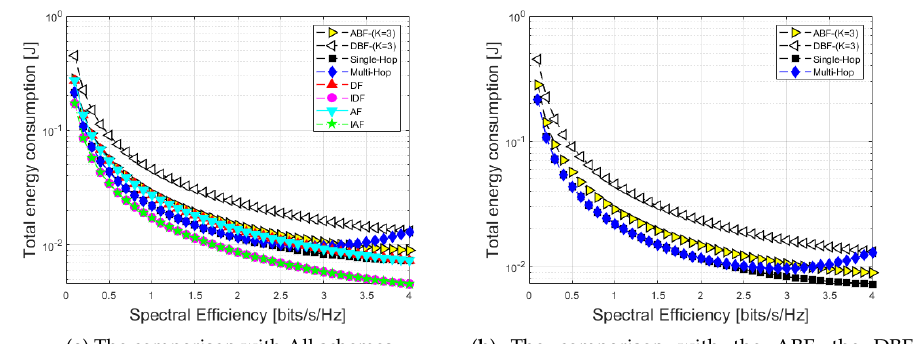
Figure 5. Optimal transmitted power.